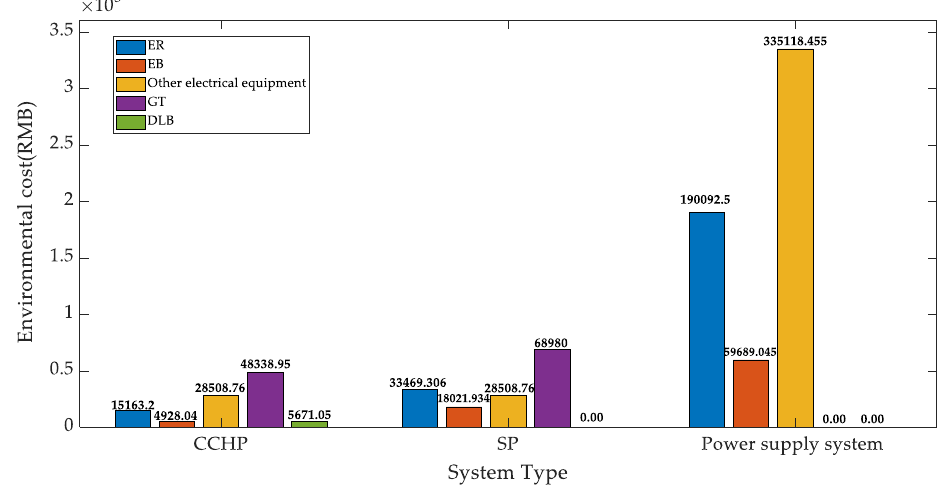
Figure 10. Environmental cost of the system among different energy supply modes.